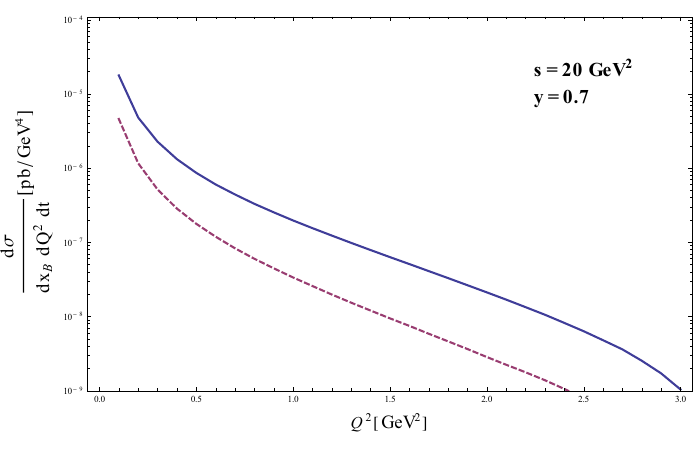
Figure 2. Contribution of σ −− to the di ff erential cross section d σ a proton (dashed line) or a neutron (solid line) at s = 20 GeV 2 , y = 0 . 7 and t = t 0 , as a function of Q 2